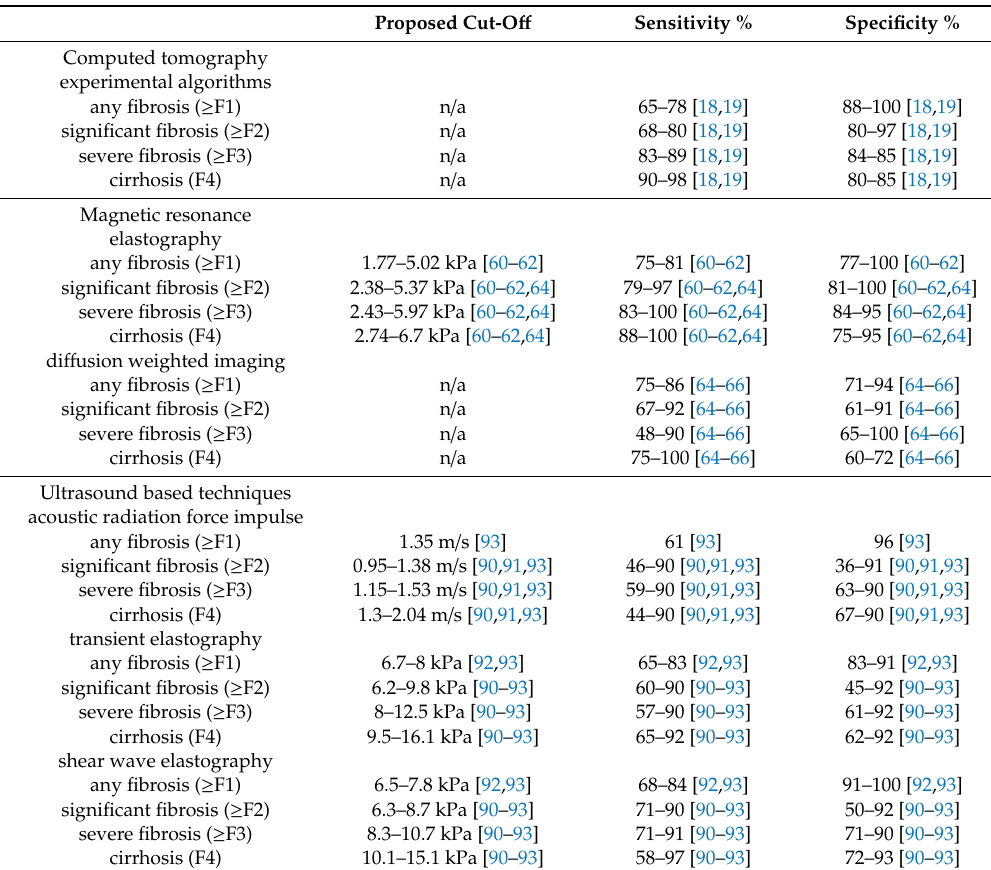
Table 2. Summary of the diagnostic parameters of di ff erent methods of fibrosis